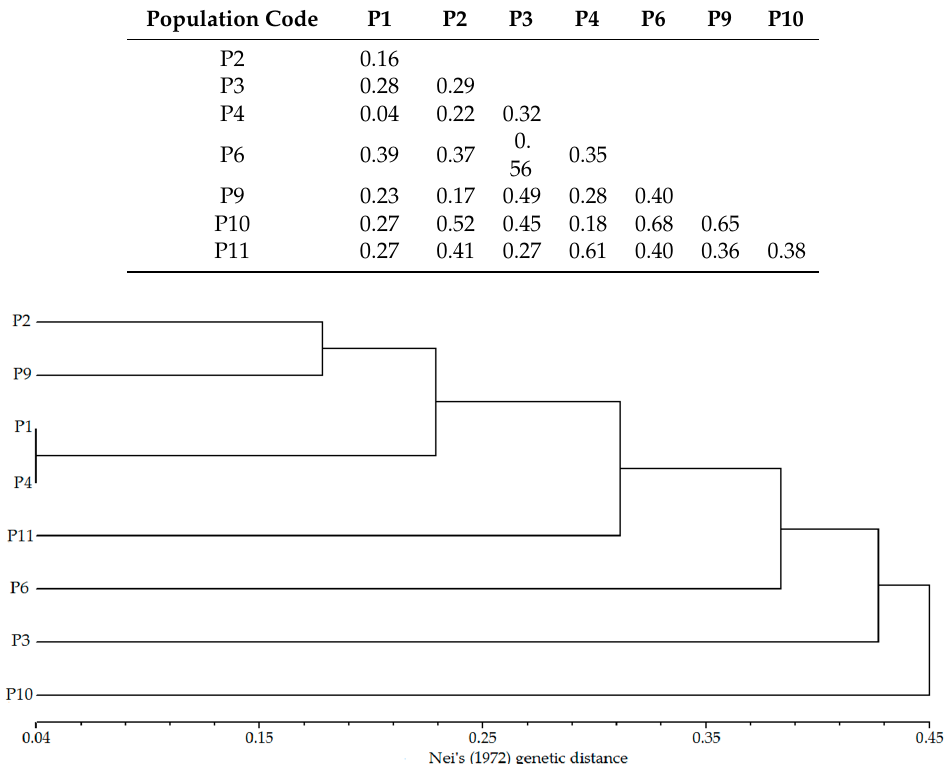
Figure 3. Genetic structural plot of eight Erythrophleum fordii populations based on STRUCTURE analysis. Blue, red and green represent different groups. Table 8. Nei’s (1972) genetic distance between eight Erythrophleum fordii populations. Population Code